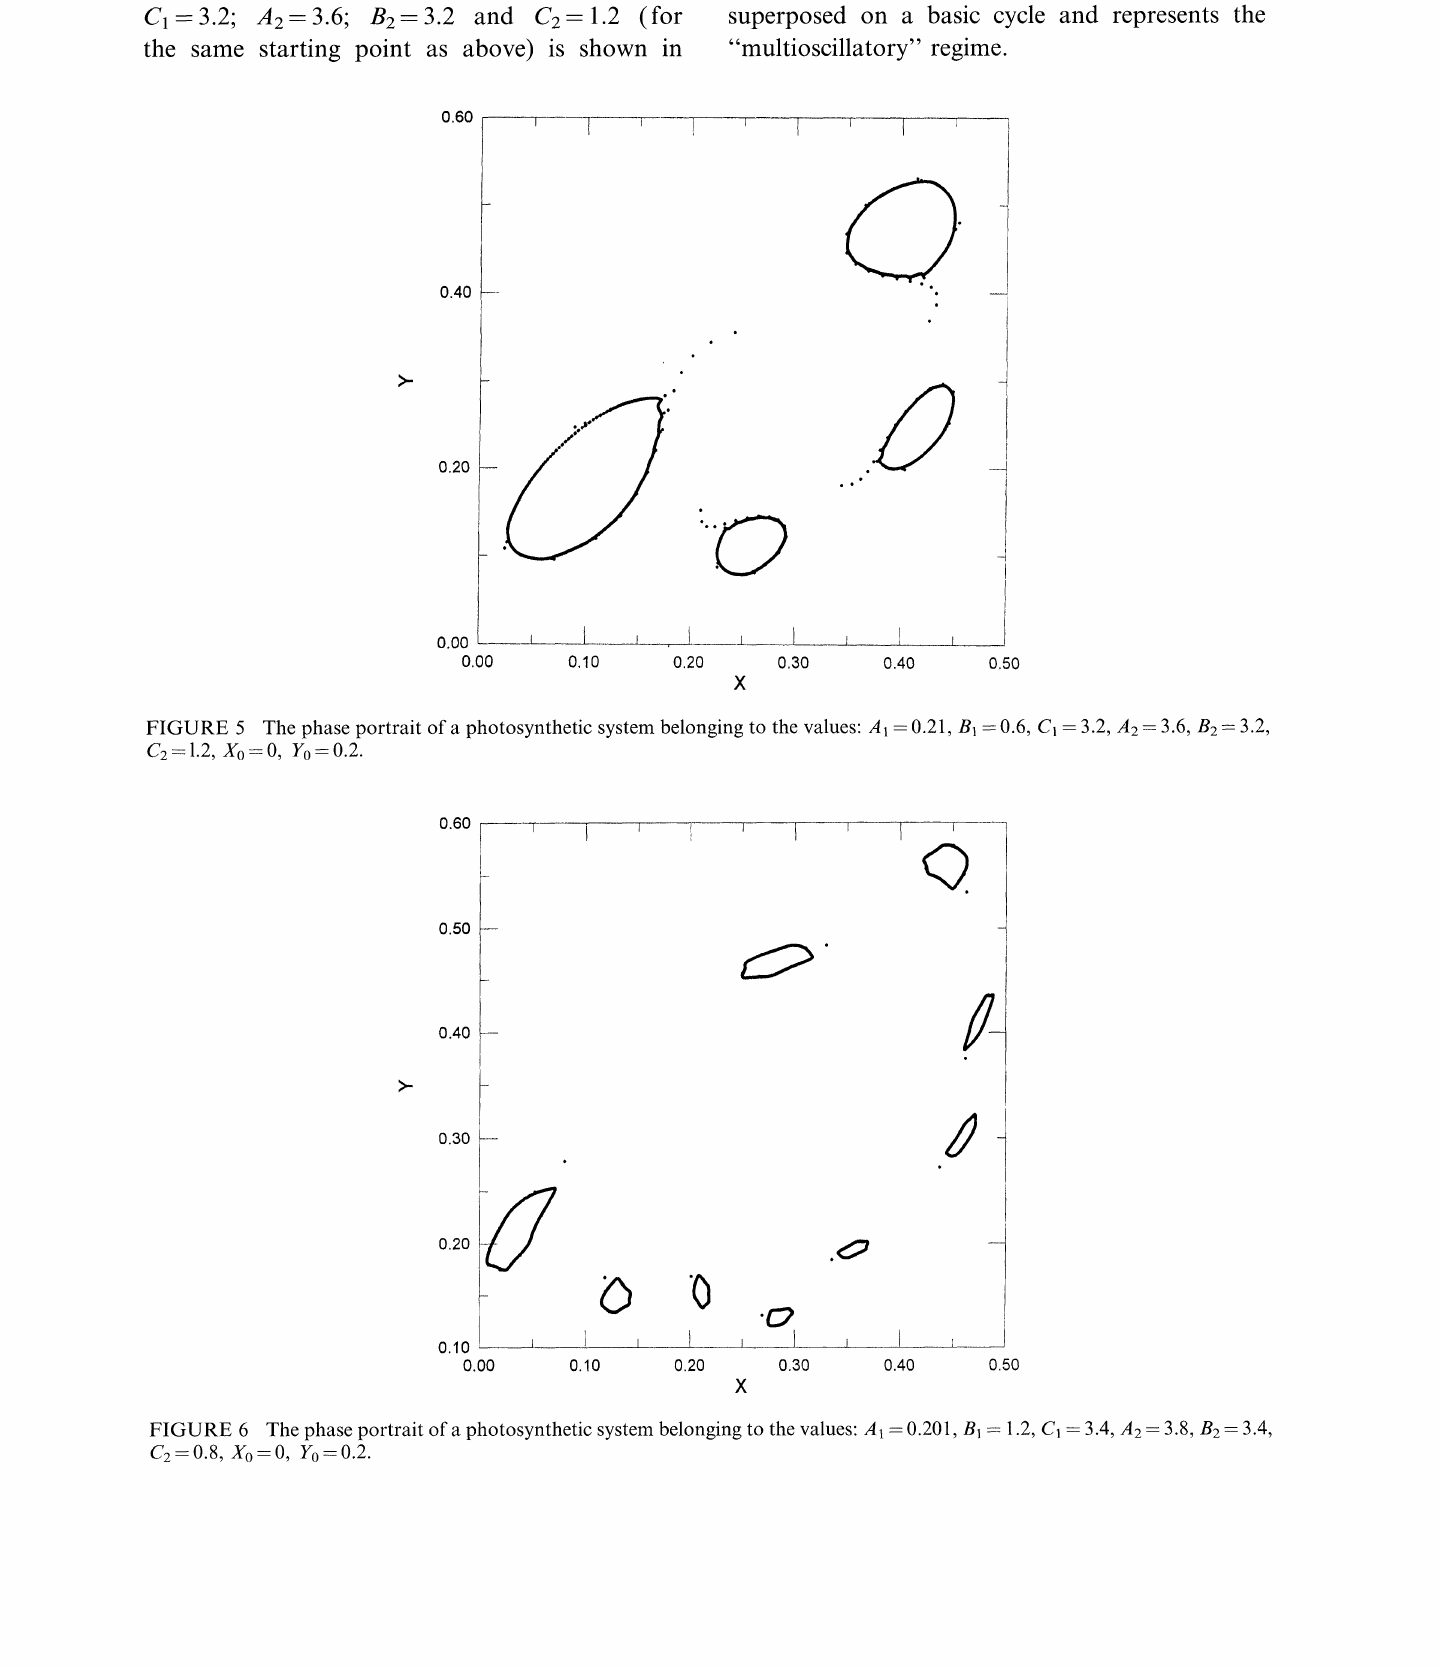
FIGURE 6 The phase portrait of a photosynthetic system belonging to the values: A 0.201,